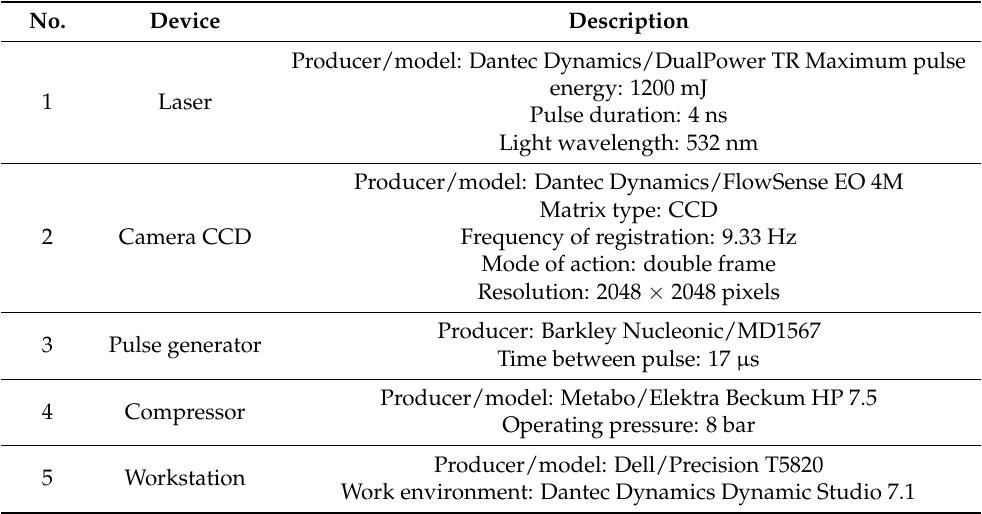
Figure 2. Test stand layout for PIV measurement. Table 1. Summary of basic parameters of the experimental and measurement setup.